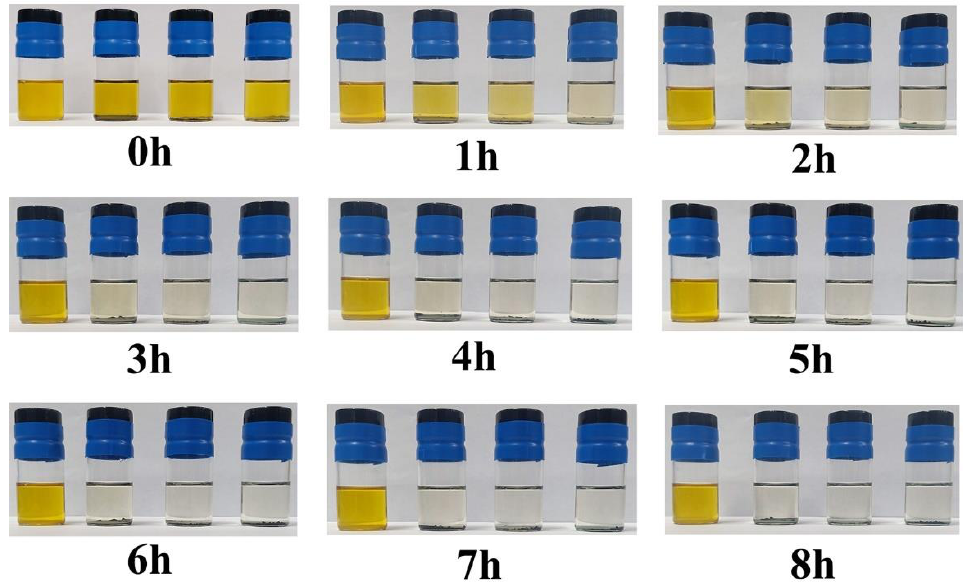
Figure 3. Time-dependent Li 2 S 6 adsorption images of control group (Li 2 S 6 ), CNT+PB@MXene, PB@MXene and PB from left to right.